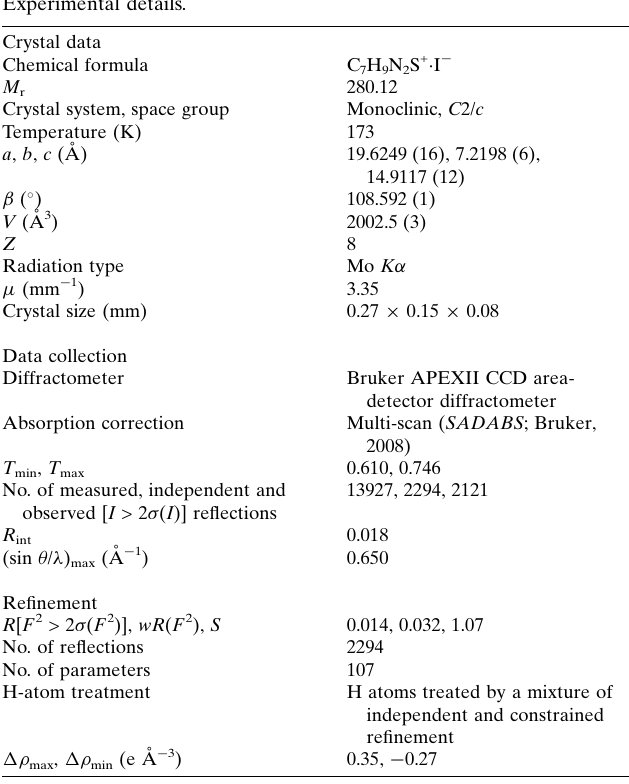
Table 2 Experimental details.